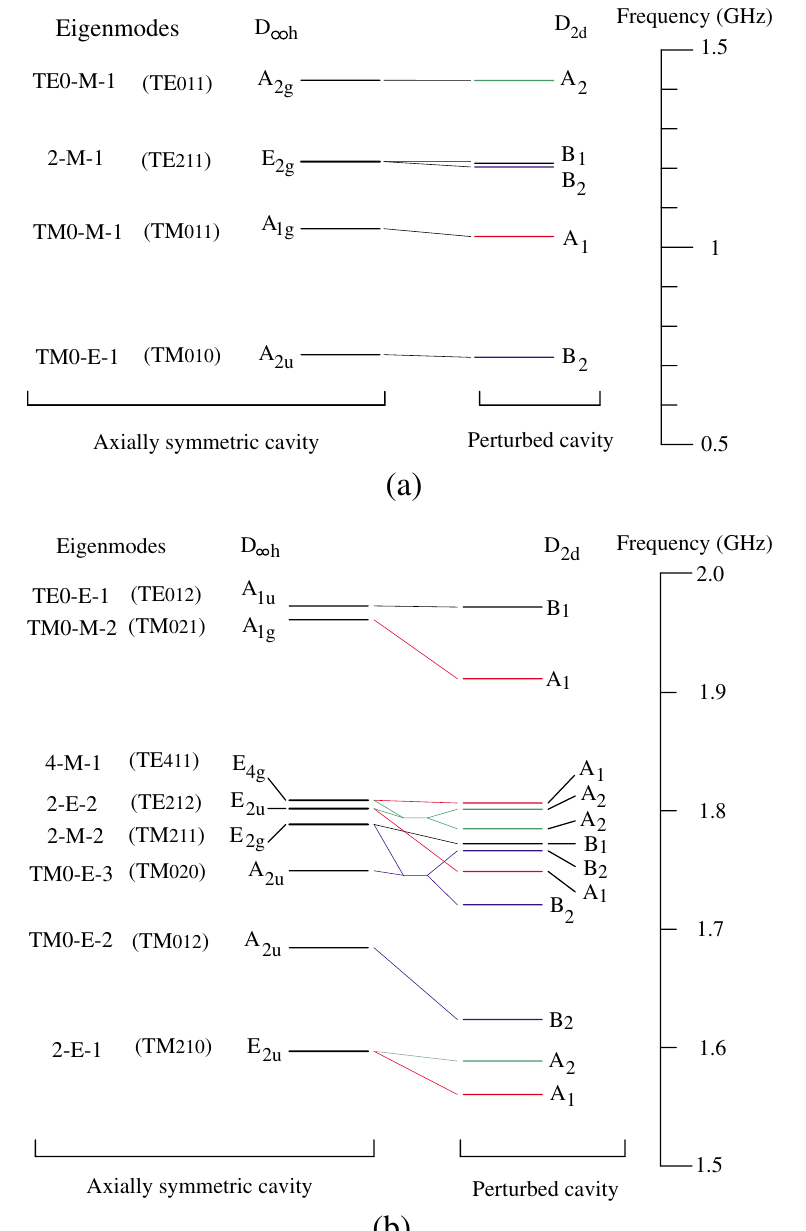
FIG. 9. (Color) Calculated spectra of eigenmodes for an axially symmetric cavity (without HOM ports) and for a perturbed cavity are shown. Frequency range: (a) 0.5–1.5 GHz, and (b) 1.5–2 GHz. (with four slots; in Fig. 7). Symmetric modes about the rotation C 2 The thick lines indicate twofold degenerate levels. Each eigenmode in the axially symmetric cavity is labeled by a set of an azimuthal index, a boundary condition (Magnetic or Electric short) on the x - y plane, and a number; the corresponding mode in an ideal pillbox cavity is indicated in